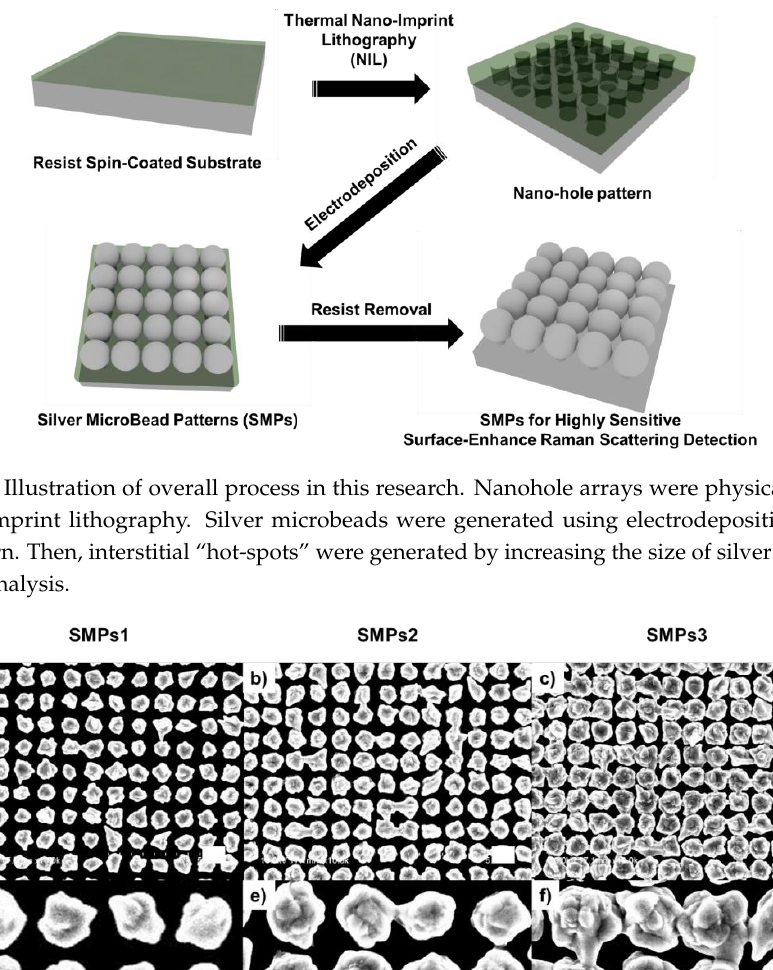
Figure 1. Morphology of SMPs with variation of deposition time. SEM images of SMPs with respect to different electrodeposition conditions. Deposition during 15 s ( a , d ), 30 s ( b , e ), and 45 s ( c , f ). Scale bars are 1 μm.